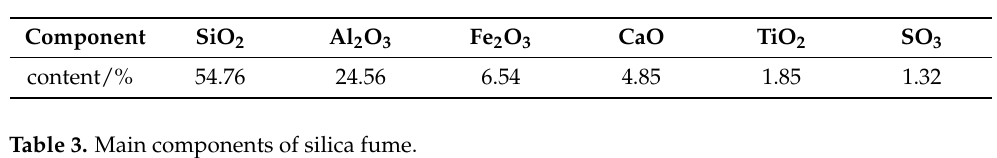
Table 2. The main components of fly ash.